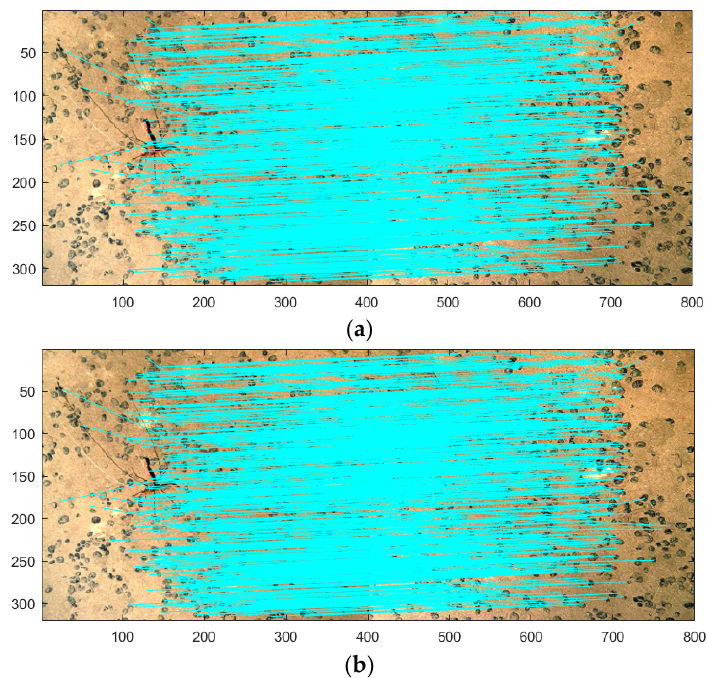
Figure 16. The registered images for T4: ( a ) I-RANSAC; ( b ) IIR. The number of matching pairs of the two algorithms cannot be directly distinguished visually. This is because the number of feature points of the two images in group T4 is too large, and the proportion of false matching pairs is very